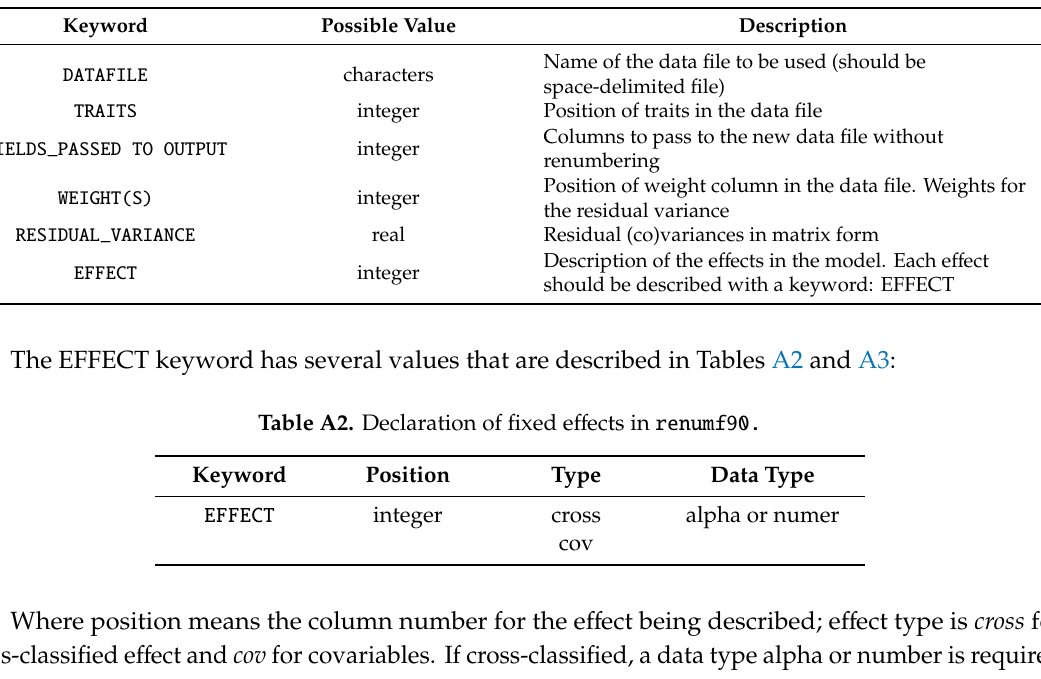
Table A1. Possible values and descriptions for the keywords used in renumf90 .